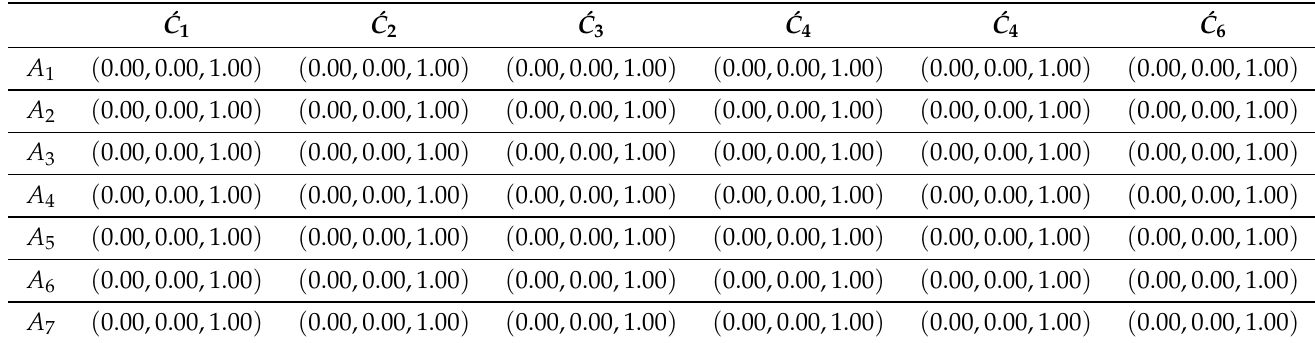
Table 13. Decision matrix D 2 .